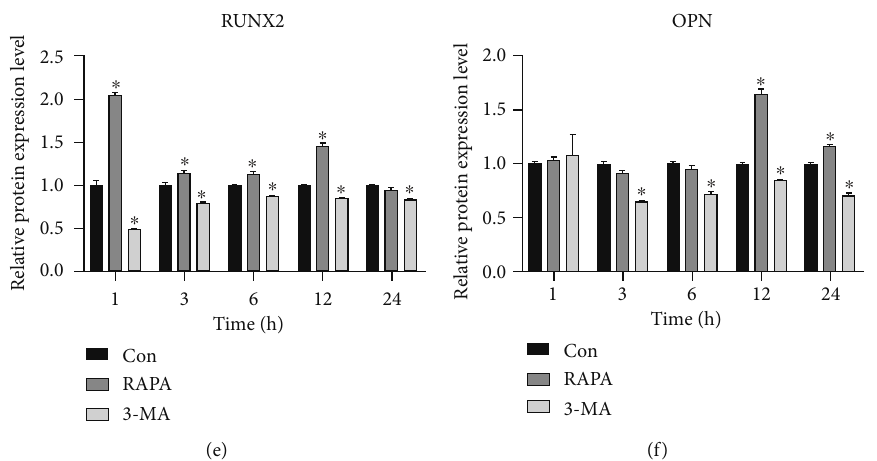
Figure 12: Changes in osteogenic levels after drug regulation. (a – c) ALP-, RUNX2-, and OPN-relative mRNA expression levels assessed by real-time PCR in the control, RAPA, and 3-MA groups. (d – f) RUNX2- and OPN-relative protein expression levels assessed by western blotting in the control, RAPA, and 3-MA groups. ∗ P < 0 : 05 . RAPA: rapamycin; 3-MA: 3-methyladenine; Con: control; PCR: polymerase chain